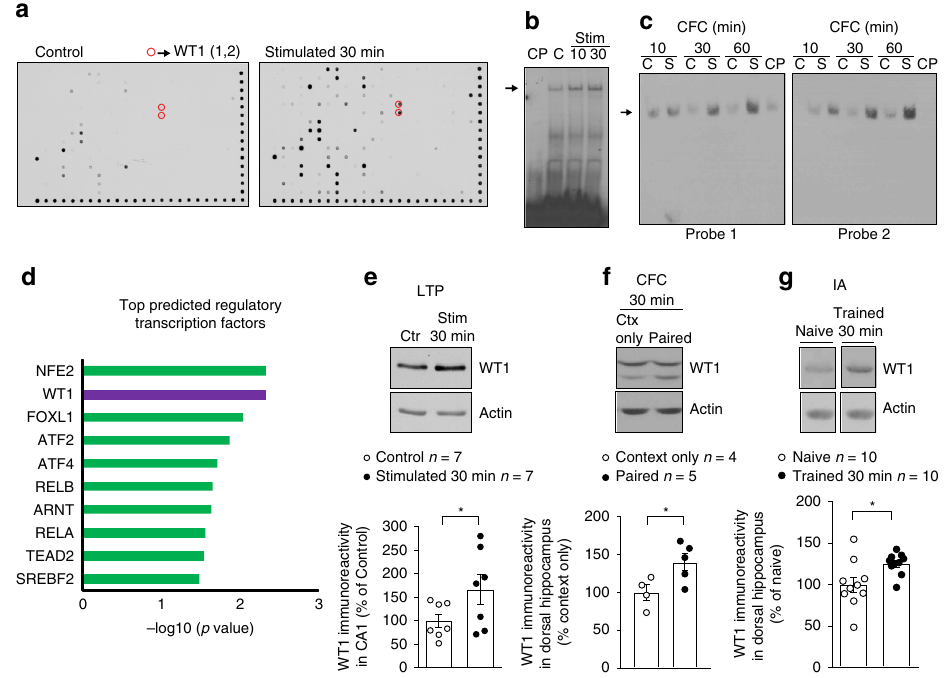
Fig. 1 WT1 expression and DNA-binding activity are induced by synaptic plasticity and learning. a Protein – DNA binding assay comparing rat hippocampal CA1 extracts from control tissue versus extracts obtained from tissue where LTP was induced. WT1 is circled in red; numbers in parentheses indicate two different DNA probes with WT1 consensus sites. b EMSA showing increased in vitro WT1 binding to a DNA consensus sequence (arrow indicates the WT1/DNA complex) 10 and 30 min after induction of LTP in hippocampal CA1 region (Stim) compared with unstimulated control (C). The speci fi city of DNA – protein binding was veri fi ed by incubation with excess unlabeled cold probe (CP). c EMSA showing increased WT1 binding to DNA (arrow indicates the WT1/DNA complex) at different time points after CFC (S, shocked group; C, context only controls). The speci fi city of DNA-protein binding was veri fi ed by incubation with excess unlabeled cold probe (CP). d Bar graph of the top ten transcription factors predicted to regulate gene expression pro fi les in rat tissue obtained 90 min after a stimulation that produced LTP. e Expression of WT1 was signi fi cantly increased in rat CA1 region 30 min after LTP induction (paired t test: * p = 0.0495). f WT1 expression in the dorsal hippocampus of rats trained in CFC (Paired) compared with non shocked rats (Ctx only) (unpaired t test: * p = 0.0385). g Expression of WT1 was signi fi cantly increased in the dorsal hippocampus of rats trained in an IA task. Protein expression was measured 30 min after training and compared with naïve rats (unpaired t test: * p = 0.0187). Data are expressed as mean ±